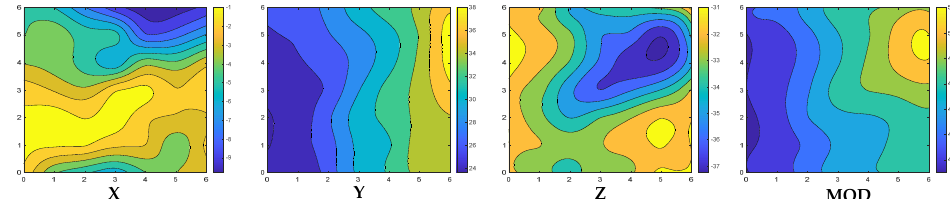
Figure 3. Spatial distribution of geomagnetic data.